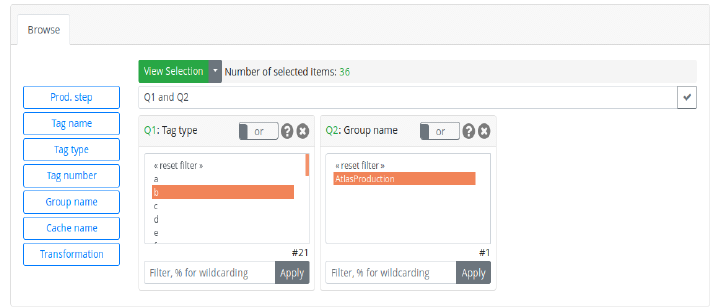
Fig. 11. The “AMI-Tags selection tool” for ATLAS.